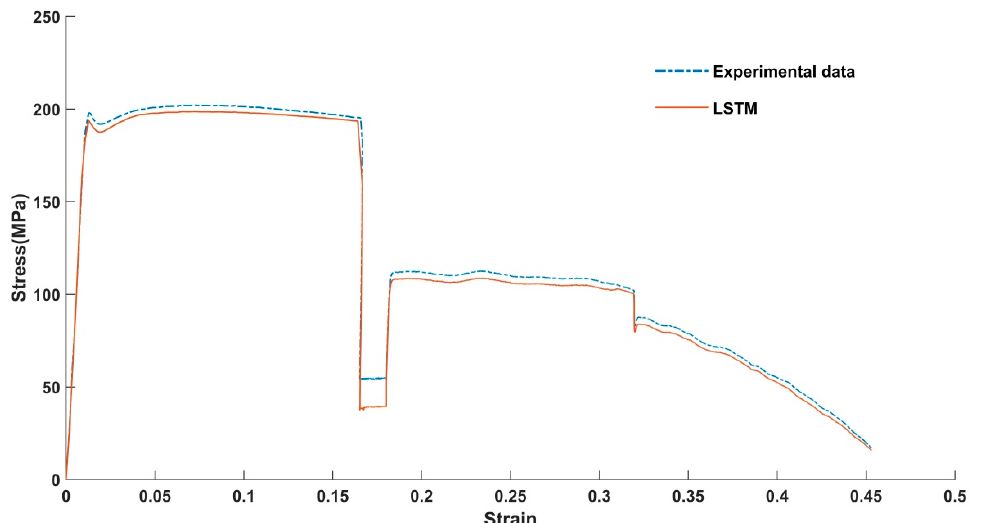
Figure 8. Comparison of predicted and measured results under complex loading paths.